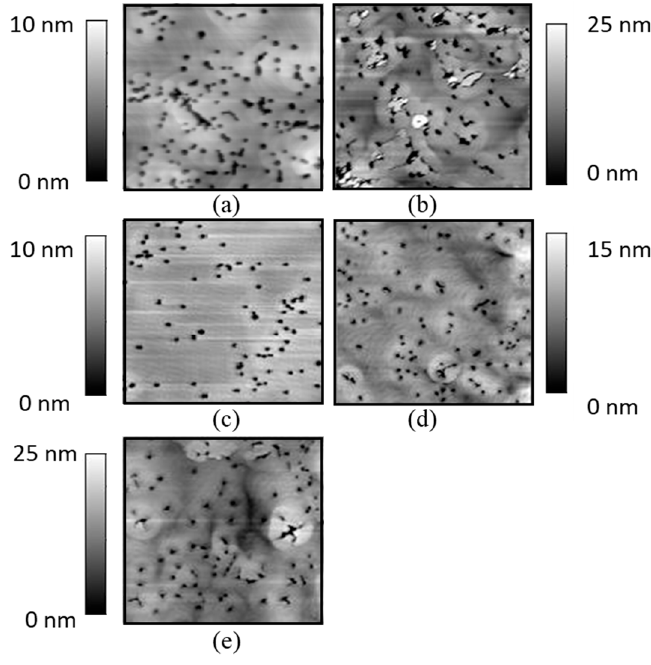
Figure 2. The 5 µm × 5 µm atomic force microscope (AFM) image of sample ( a ) A0 with 200 nm In 0.08 Ga 0.92 N before regrowth, ( b ) A1 upon regrowth of 100 nm In y Ga 1 − y N, ( c ) C0 with 80 nm thick In 0.09 Ga 0.91 N before regrowth, ( d ) C1 upon regrowth of 100 nm In y Ga 1 − y N, ( e ) C2 upon regrowth of 200 nm In y Ga 1 − y N.